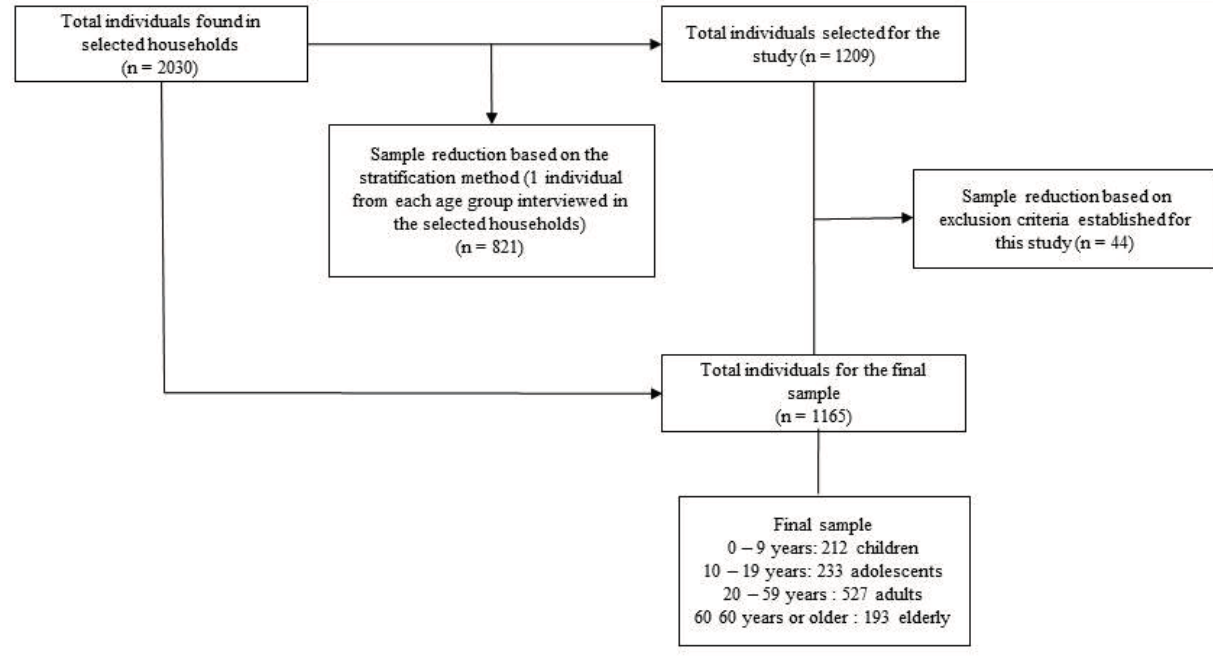
Figure 1. Flow diagram for sample